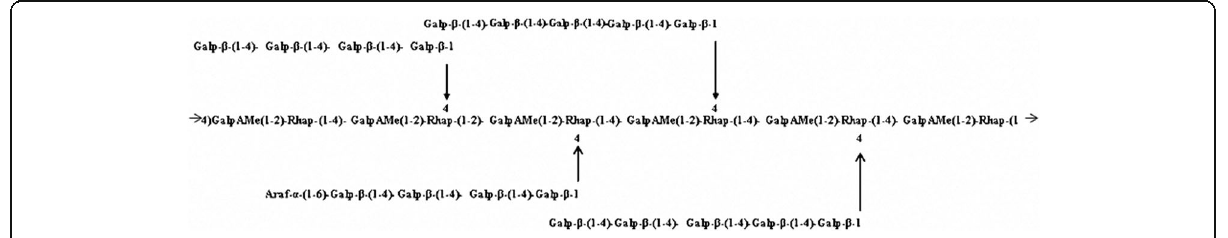
Fig. 2 An example of the chemical structure of polysaccharides isolated from okra vegetable via hot water extraction